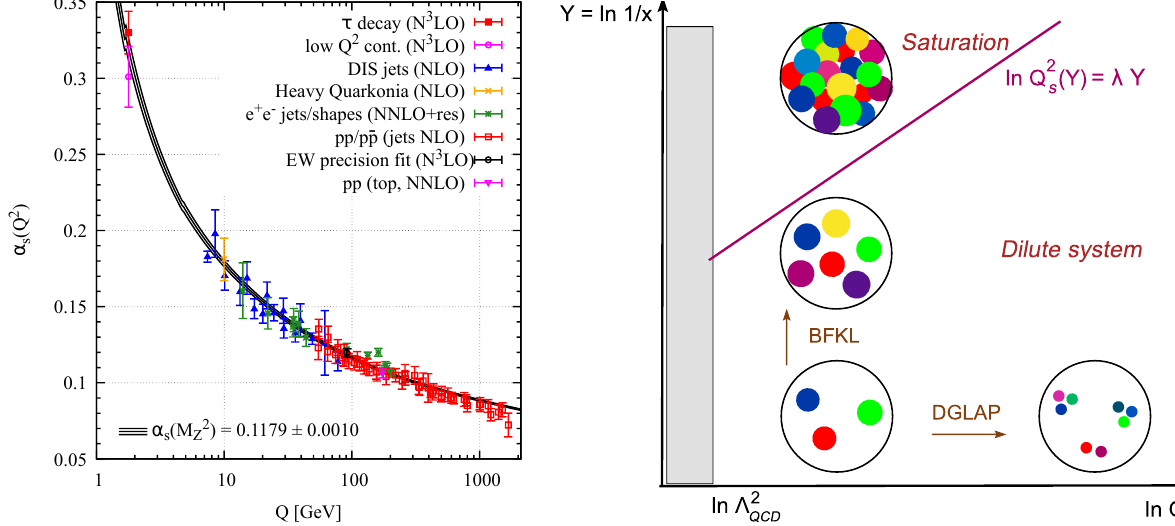
Figure 9.3: Summary of measurements of – s as a function of the energy scale Q . The respective Figure 1. On the left panel, the QCD interaction strength α s as a function of the momentum transfer Q at the next-to-leading degree of QCD perturbation theory used in the extraction of – s is indicated in brackets (NLO: next-to-leading order; NNLO: next-to-next-to-leading order; NNLO+res.: NNLO matched to a order of the PT. The figure is taken from Ref. [24]. On the left panel, the QCD evolution of the characteristic parton (quark resummed calculation; N 3 LO: next-to-NNLO). and gluon) density and length-scale with respect to rapidity Y = ln ( 1/ x ) and ln Q 2 . The figure is taken from Ref. 9.4.3 Deep-inelastic scattering and global PDF fits: StudiesofDISfinalstateshaveledtoanumberofprecisedeterminationsof – s : acombination[501] of precision measurements at HERA, based on NLO fits to inclusive jet cross sections in neutral current DIS at high Q 2 , provides combined values of – s at dierent energy scales Q , as shown in Fig. 9.3, and quotes a combined result of – s ( M 2 Z ) = 0 . 1198 ± 0 . 0032. A more recent study of multijet production [373], based on improved reconstruction and data calibration, confirms the generalpicture,albeitwithasomewhatsmallervalueof – s ( M 2 Z )=0 . 1165 ± 0 . 0039,stillatNLO.An